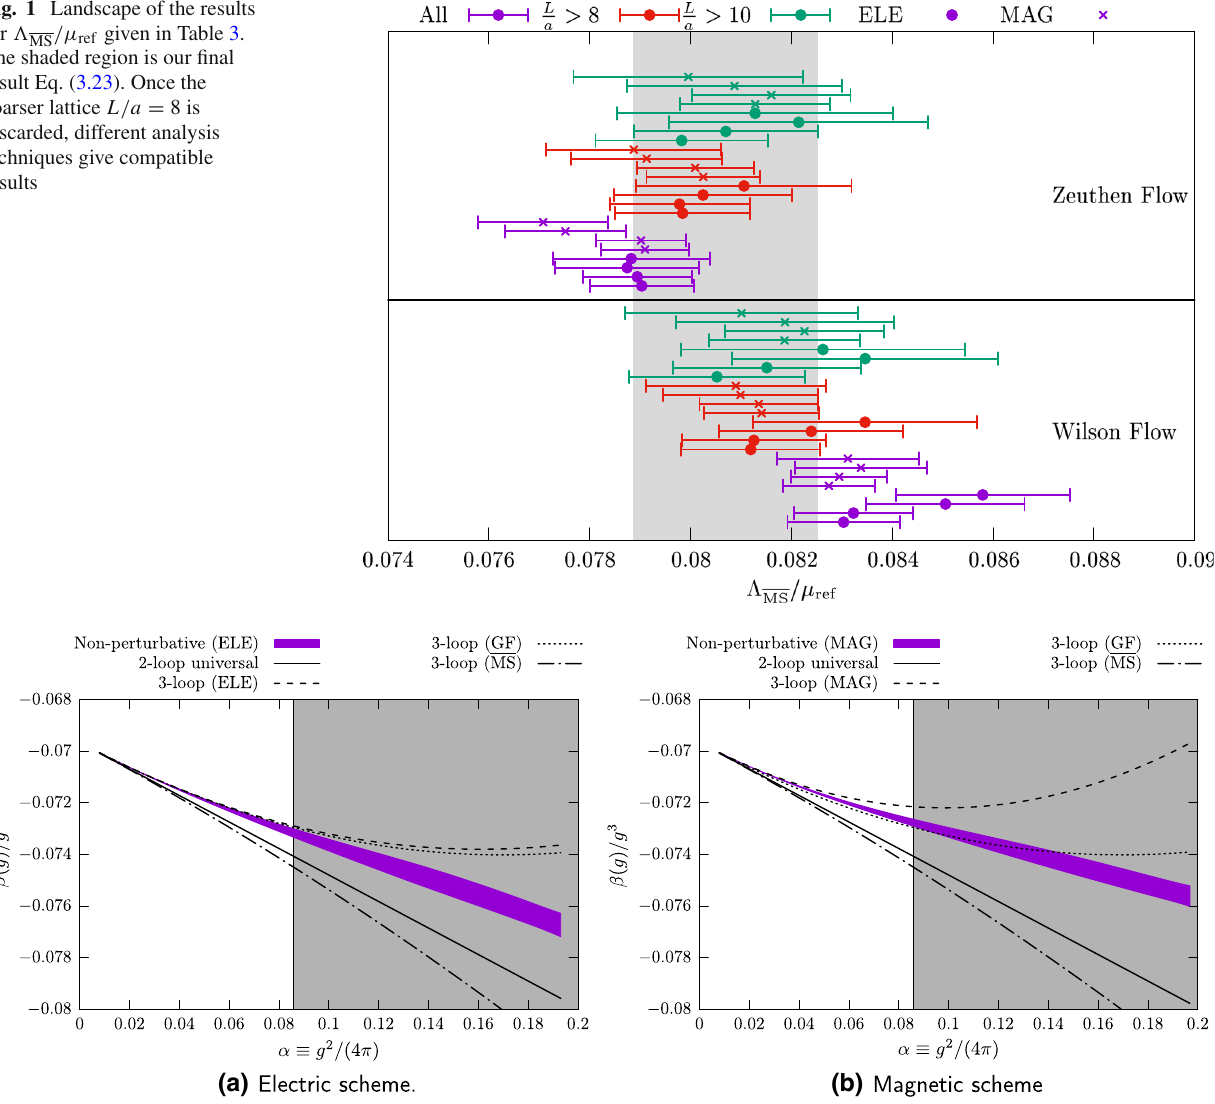
Fig. 1 Landscape of the results /μ for (cid:3) ref given in Table 3. MS The shaded region is our final result Eq. (3.23). Once the coarser lattice L / a = 8 is